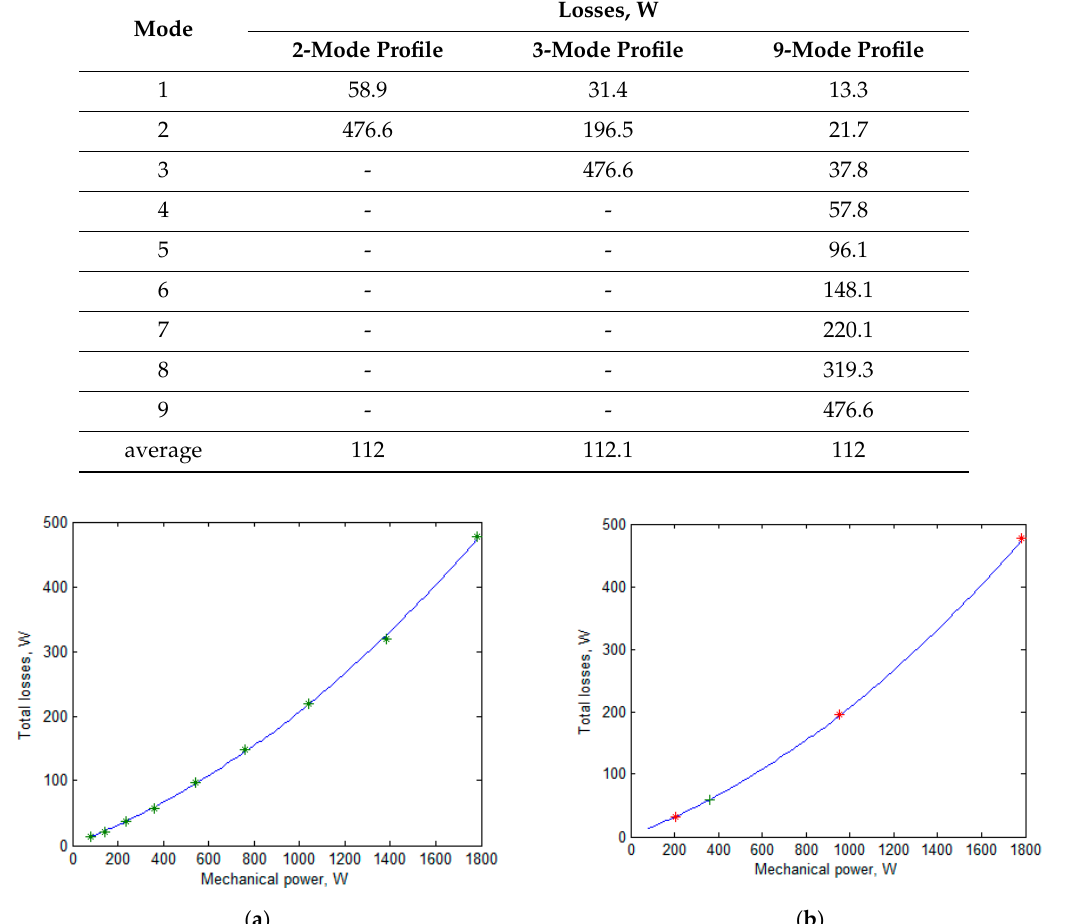
Figure 6. The calculated losses of the initial FSG design and their approximation with quadric polynomial: ( a ) the points of the nine-mode profile and the approximating quadric trinomial; ( b ) the same quadric trinomial and the points of the two-mode and three-mode substituting profiles. Table 7. The calculated losses of the initial FSG design.